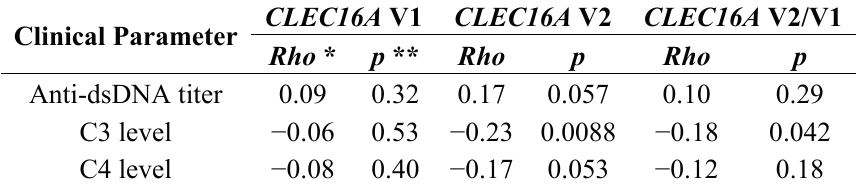
Figure 3. Limited correlation of CLEC16A expression with SLE disease severity. Scatter plots showing expression of ( A ) V1; ( B ) V2; and ( C ) V2/V1 ratio against SLE disease activity index (SLEDAI) of 190 SLE patients. Spearman’s Correlation analysis was performed ( Rho = 0.18, p = 0.04 for V1; Rho = 0.12, p = 0.17 for V2; Rho = − 0.05, p = 0.60 for V2/V1). Table 3. Correlation analyses of expressions of CLEC16A isoforms with twelve clinical parameters in SLE